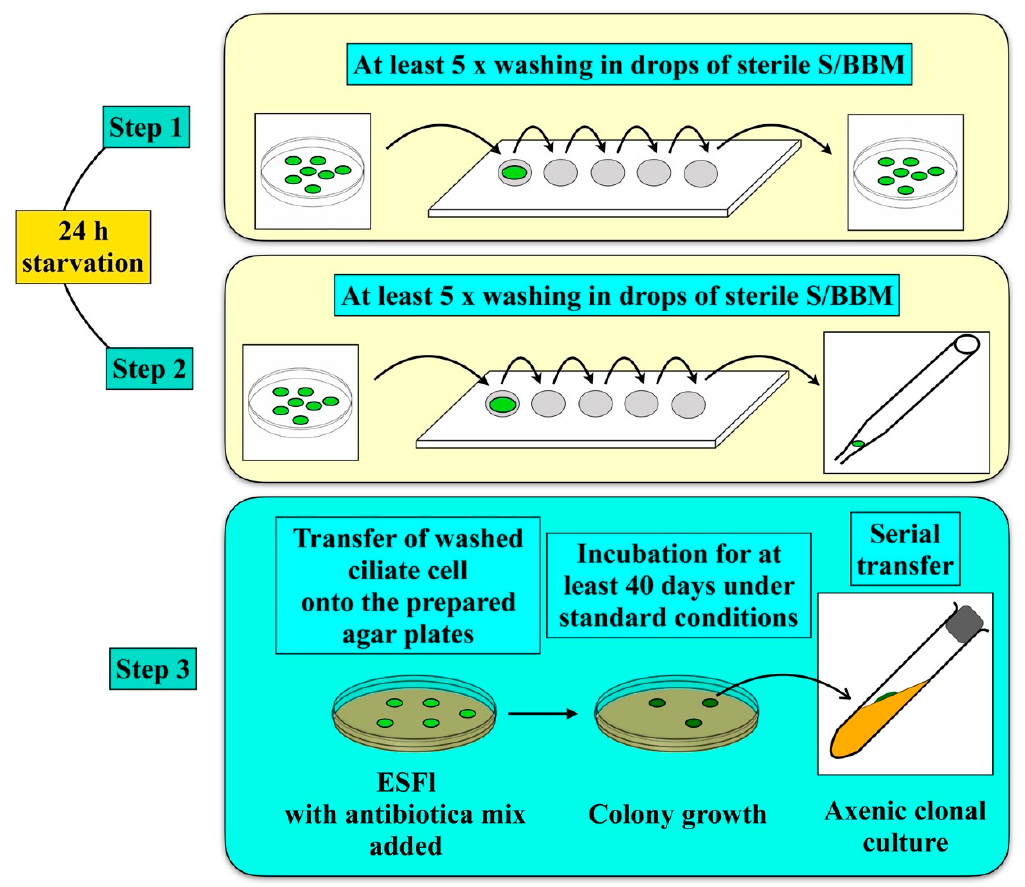
Figure 2. Working scheme for isolating the green algal endosymbionts of Paramecium bursaria .